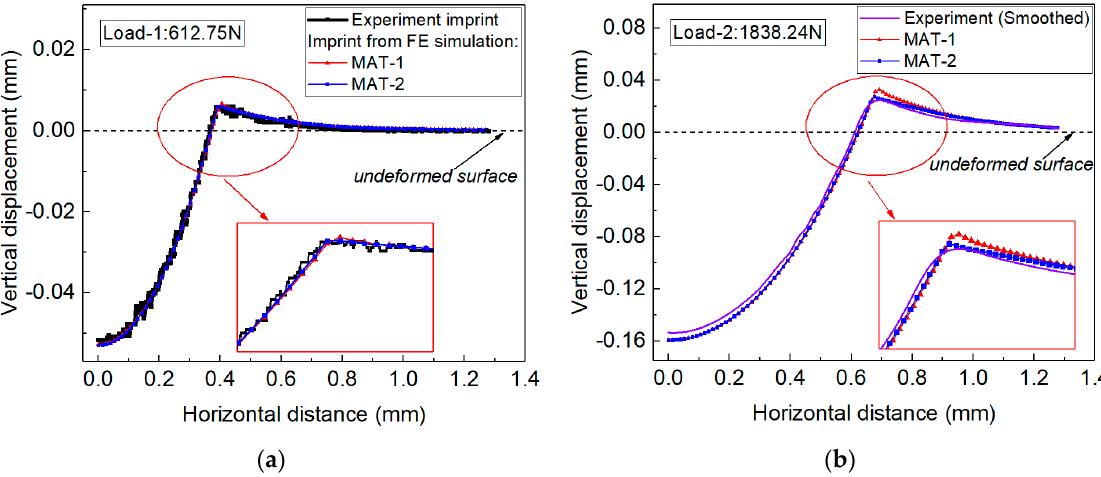
Figure 11. The FE simulated imprint snapshots using the estimated elastoplastic properties of MAT-1 and MAT-2 in situation one: ( a ) simulated imprint snapshots using indentation Load-1; ( b ) simulated imprint snapshots using indentation Load-2.